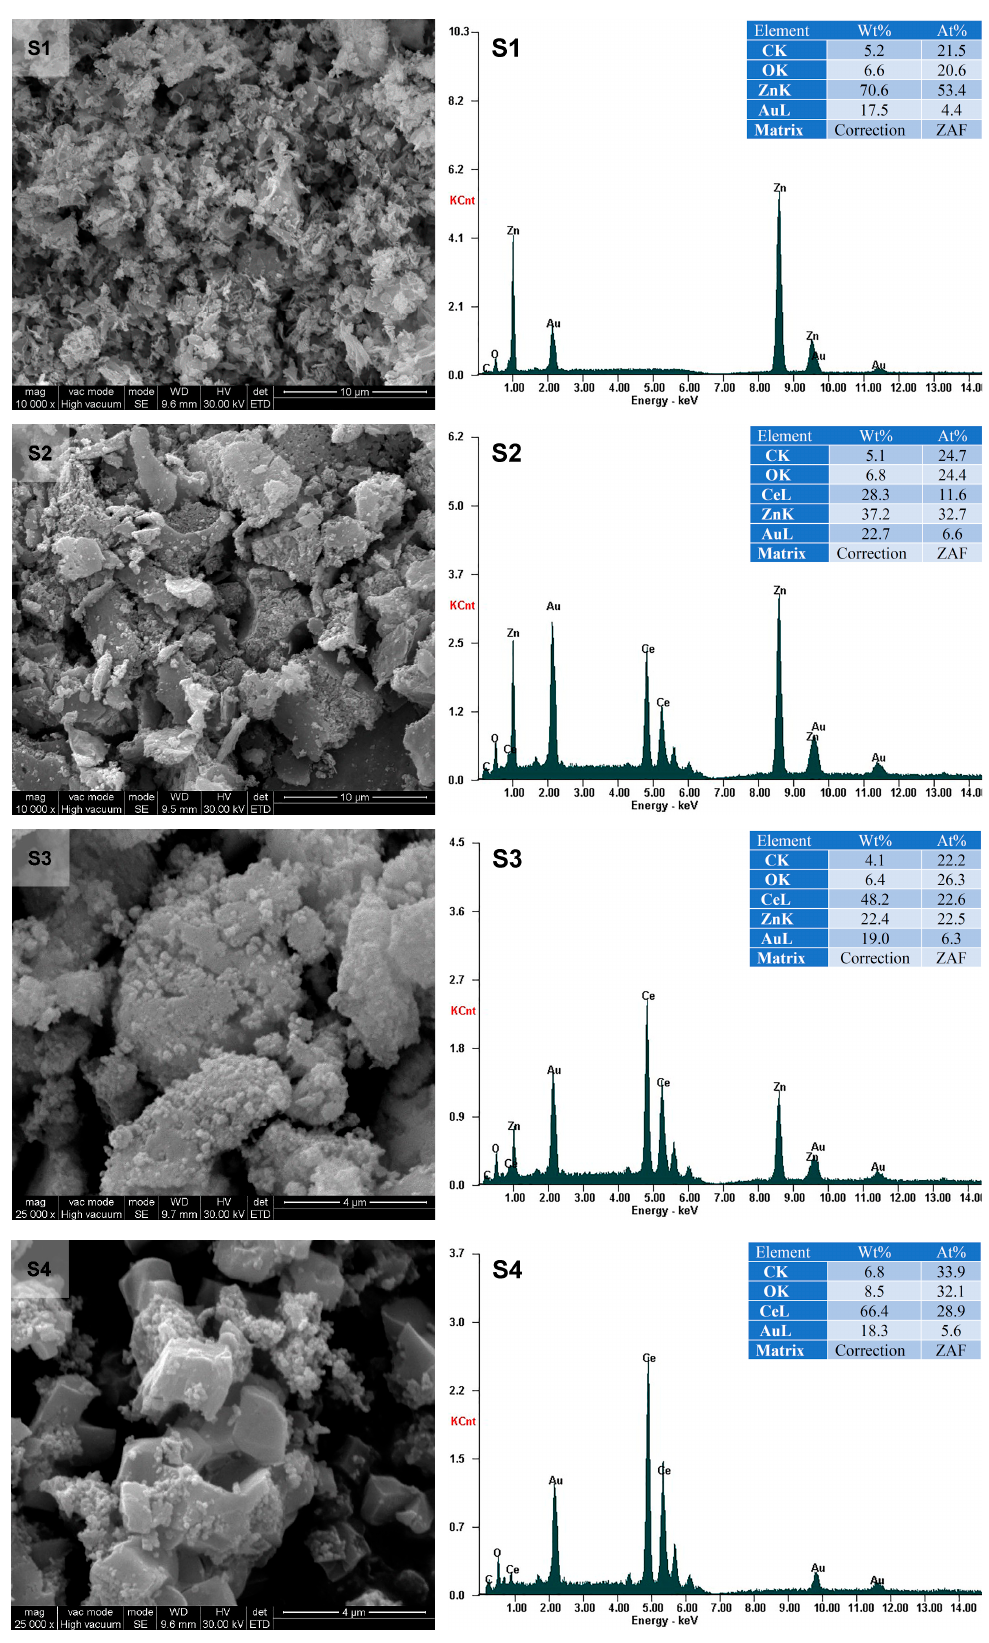
Figure 2. SEM micrographs ( left ) and EDAX pattern of the S1–S4 samples ( right ).